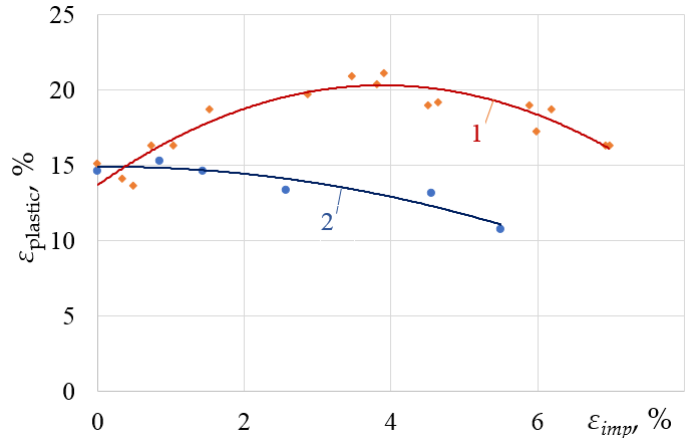
Figure 8. Dependence of the maximum strain of the VT23 alloy rolled in different directions on the increase in the dynamic strain increment ε imp of specimens during the DNP: 1—longitudinal direction. [36]; 2—transverse direction.